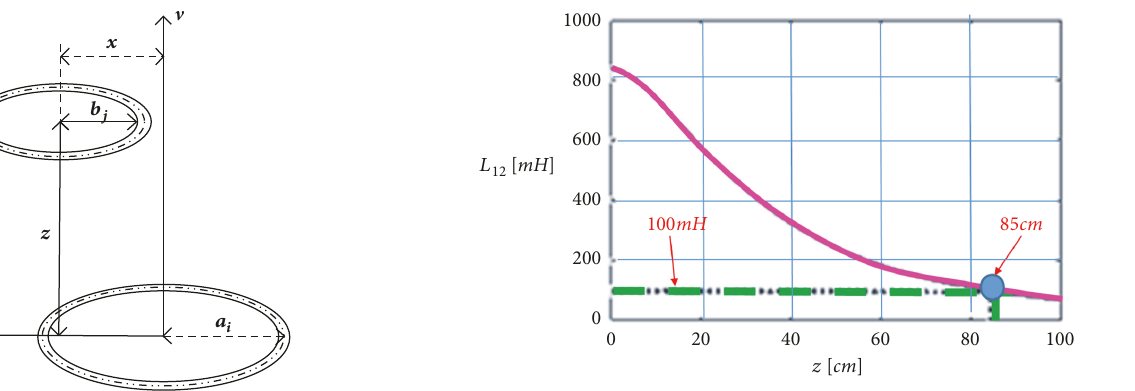
Figure 7: Scheme adopted to calculate self-inductance and mutual inductances of coils.